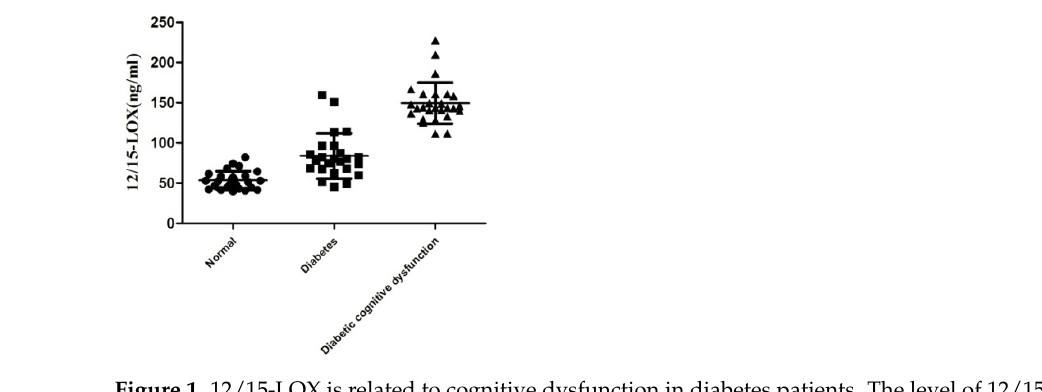
Figure 2. The establishment of diabetes model. Fasting blood glucose level ( A ). Random blood glu- cose level ( B ). Insulin level ( C ). TG level ( D ). T − CHO level ( E ). LDH level ( F ). ** p < 0.01 compared with normal group.